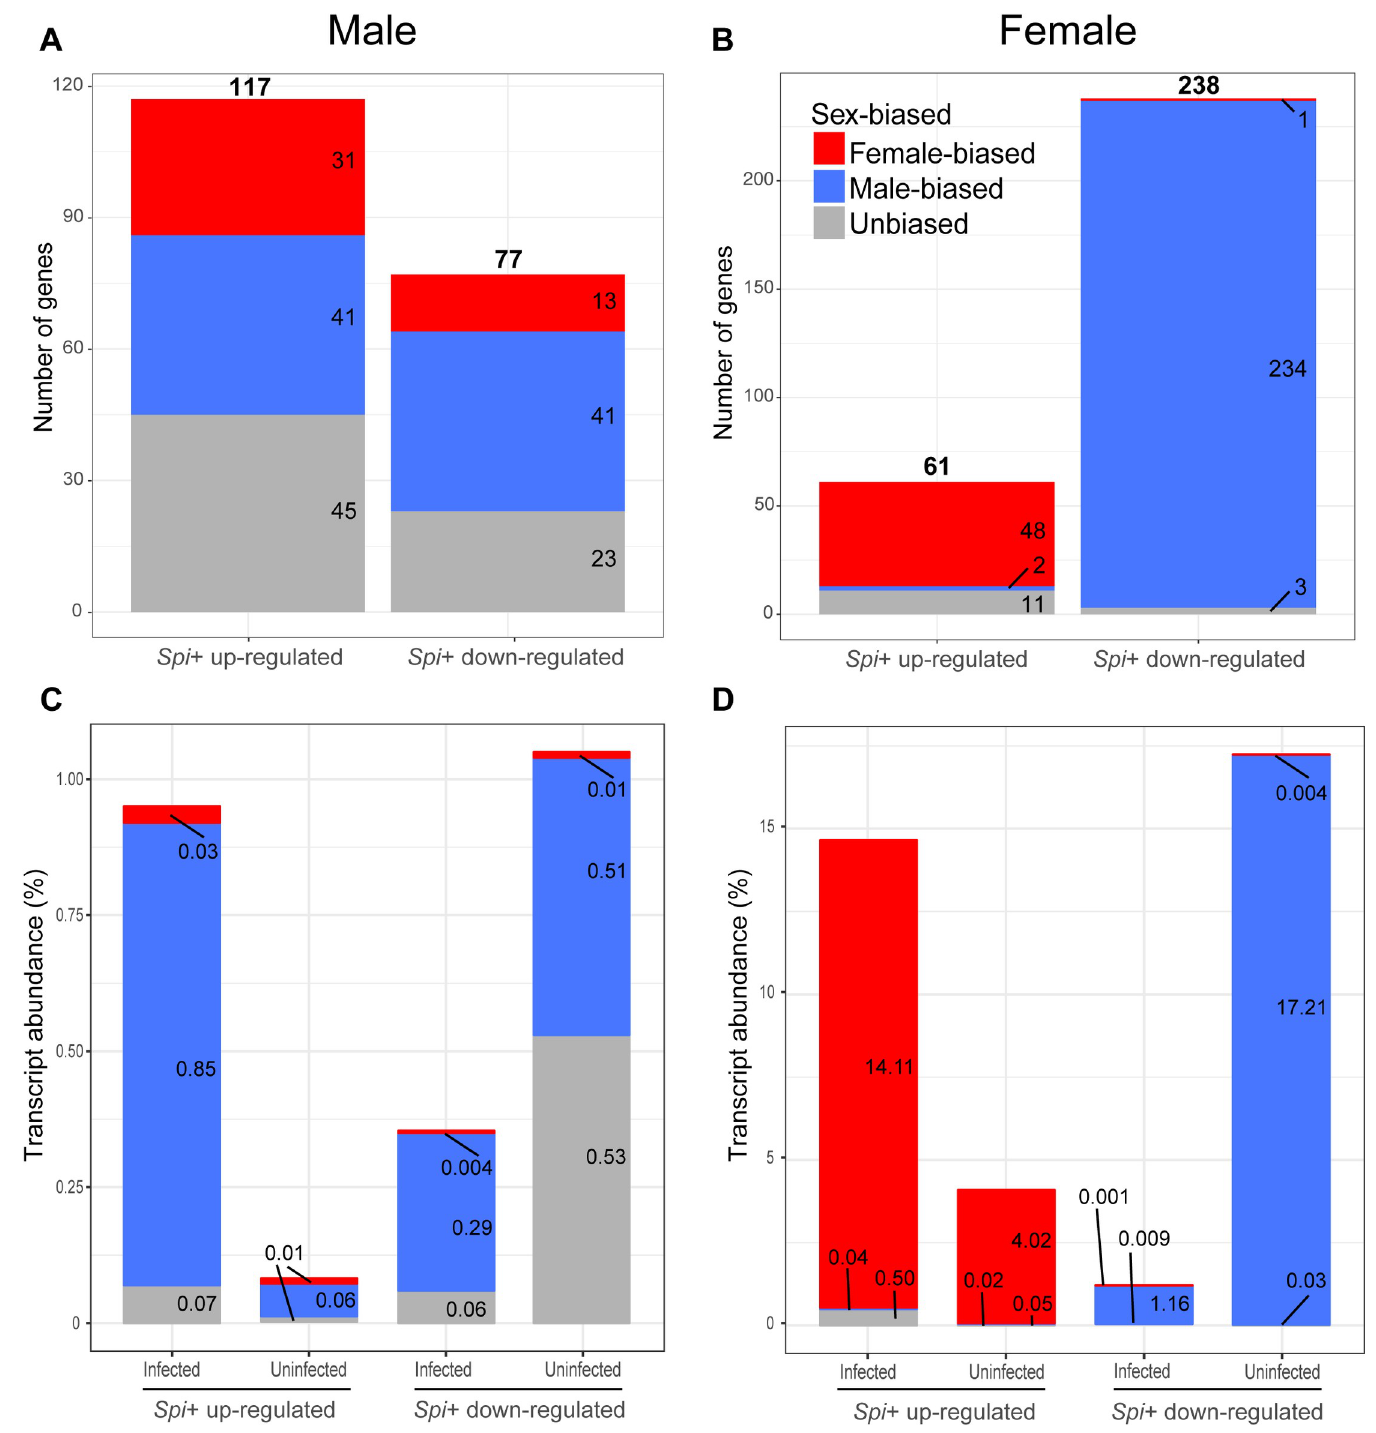
Fig 2. Enrichment of genes with sex-biased expression that are differentially expressed between Gff Spi+ and Gff Spi- flies. (A) The number of genes with sex-biased expression that are up- and down-regulated in Gff Spi+ males. (B) The number of genes with sex-biased expression profiles that are up- and down-regulated in Gff Spi+ females. (C) Transcript abundance (%) of up- and down-regulated genes relative to total transcript abundance in Gff Spi+ and Gff Spi- males. (D) Transcript abundance of up- and down-regulated genes relative to total transcript abundance in Gff Spi+ and Gff Spi- females. Female-biased genes are represented as red and male-biased genes as blue. Genes with no sex-bias are indicated as